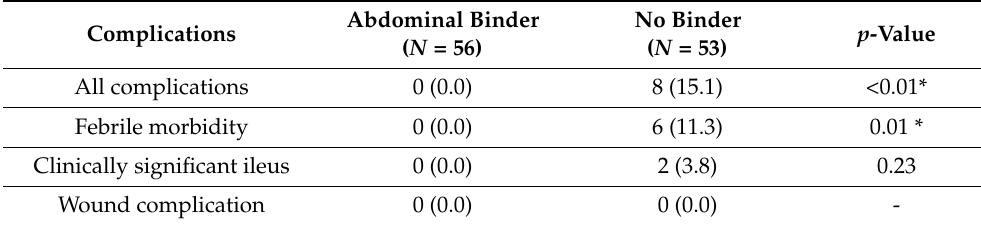
Table 5. Postoperative